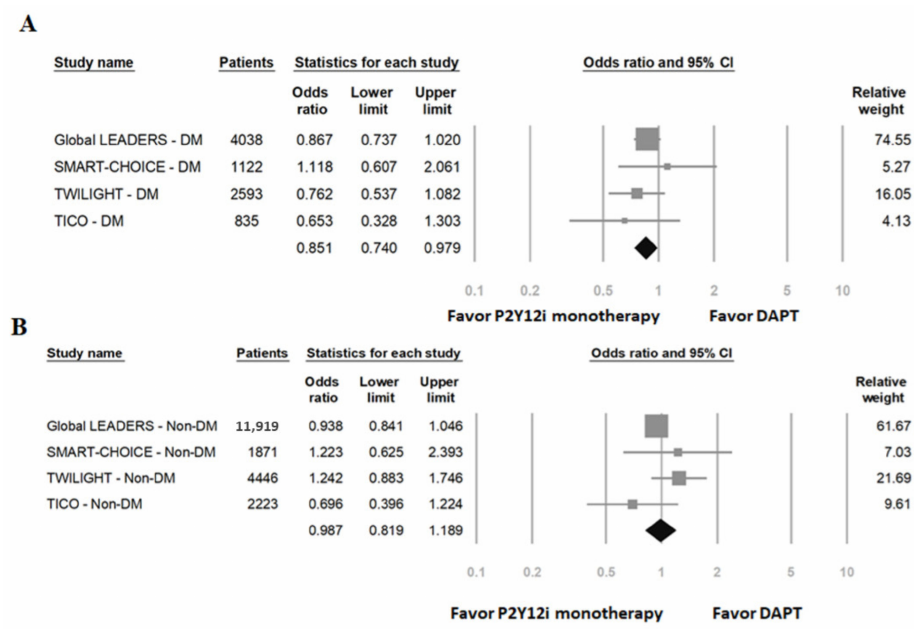
Figure 3. The primary efficacy outcomes (a composite of major adverse cardiovascular and cere- brovascular events) of P2Y12 inhibitor monotherapy compared to 12-month DAPT. ( A ) Patients with DM; ( B ) patients without DM.